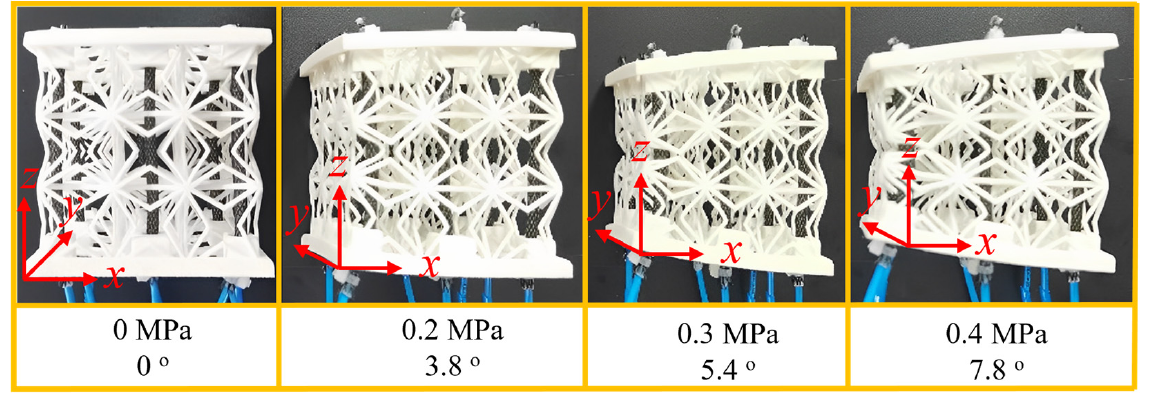
Figure 14. Unidirectional bending deformation of 3D ZPR honeycomb under different pressure.